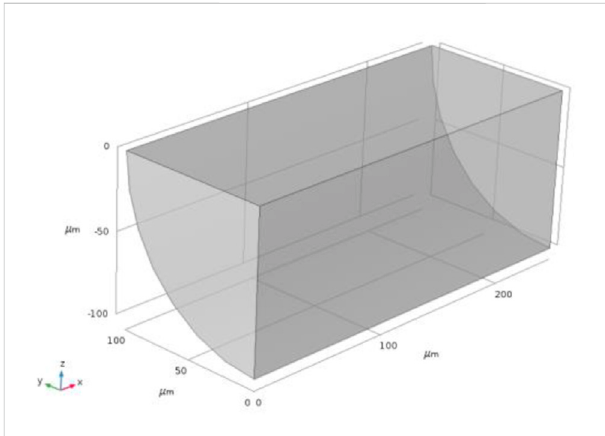
FIGURE 1 Basic schematic of straight tube generated using